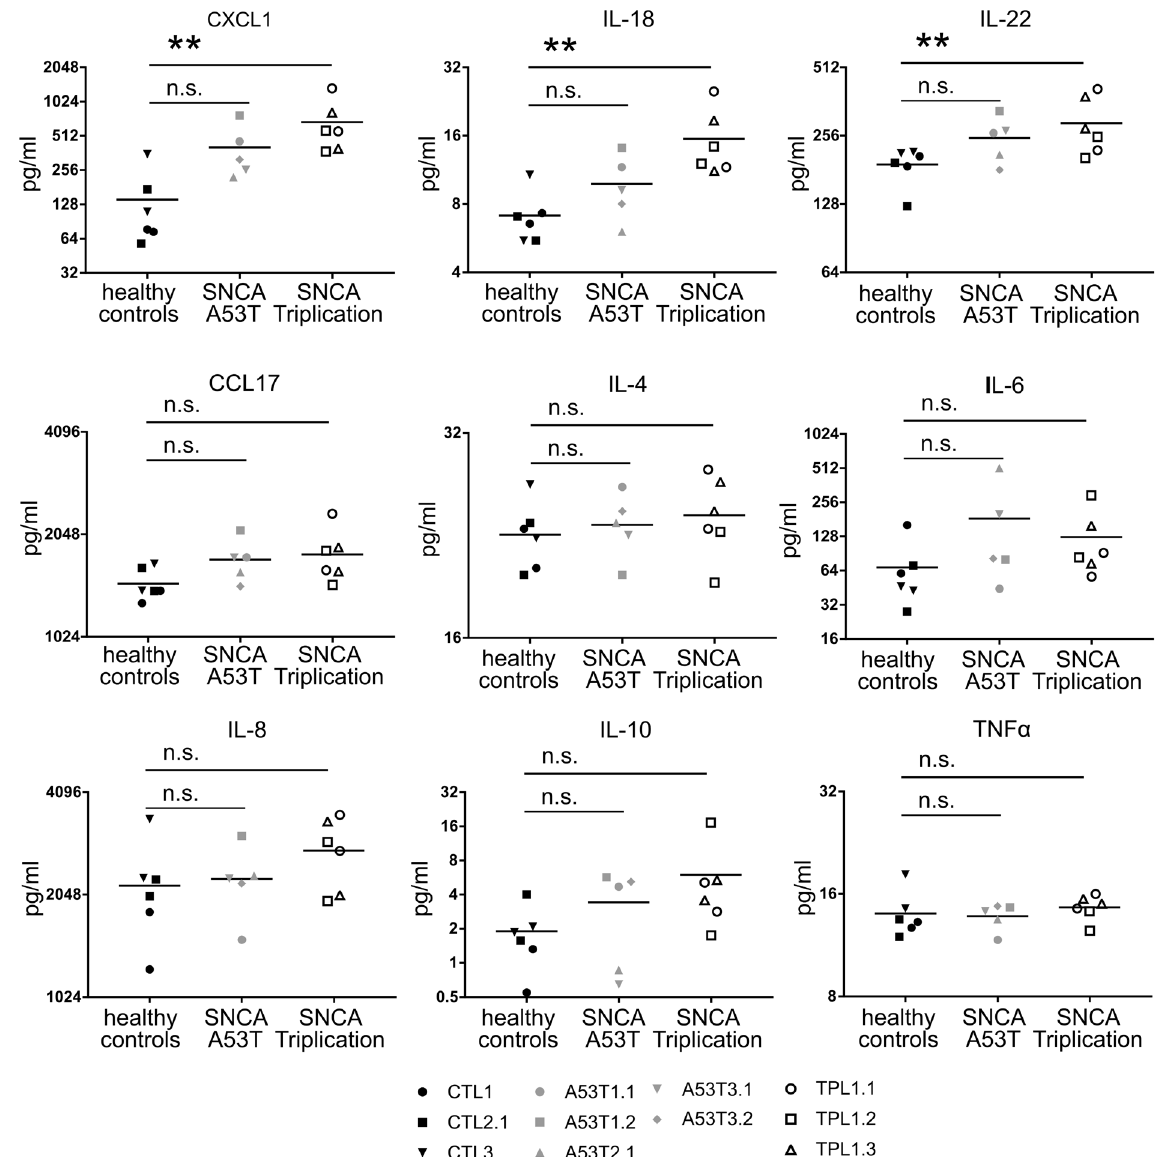
Figure 2. Cytokine and chemokine release by healthy control and SNCA mutant pMacs. Supernatants from pMac were assayed with Cytokine & Chemokine 34-Plex Human ProcartaPlex. Selected results are shown